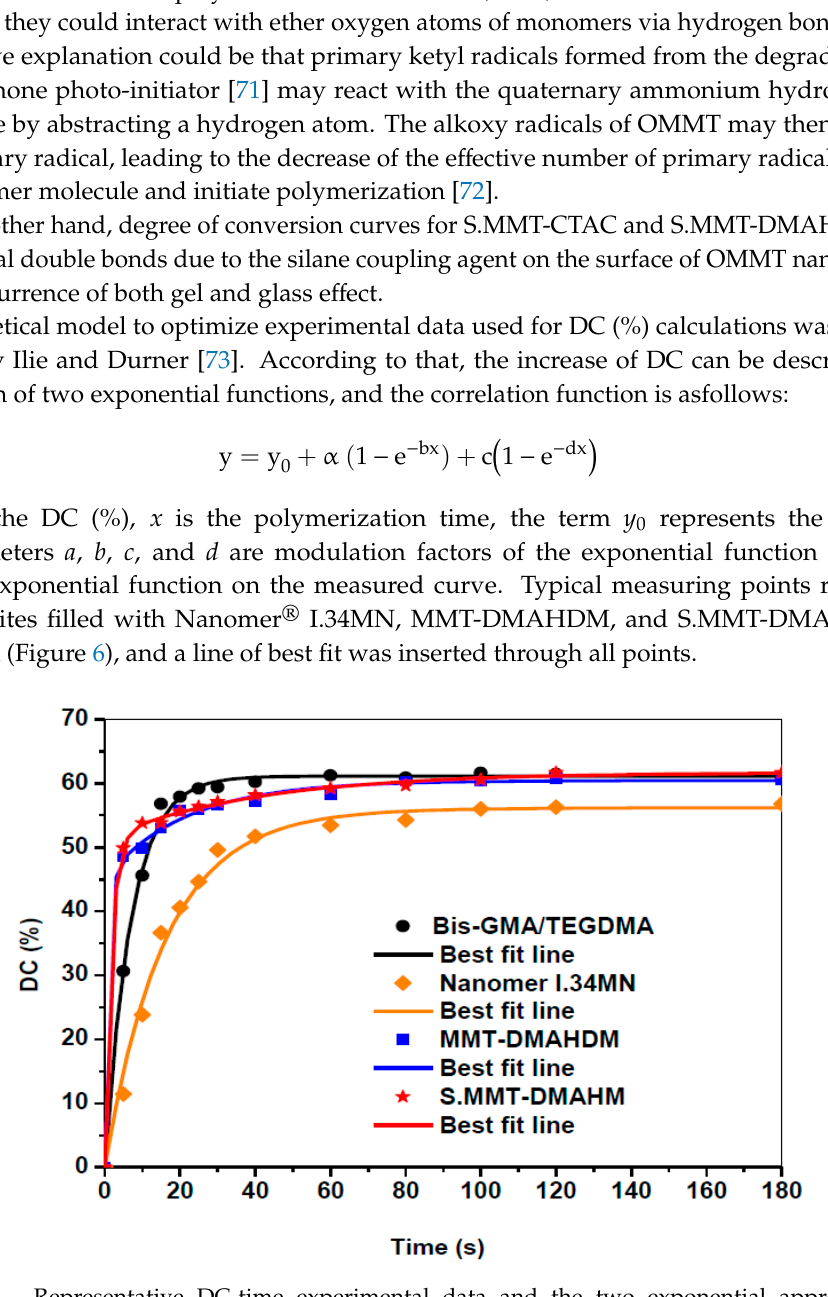
Figure 6. Representative DC-time experimental data and the two exponential approximate functions, for pure Bis-GMA/TEGDMA matrix and nanocomposites filled with Nanomer ® I.34MN, MMT-DMAHDM and S.MMT-DMAHDM. Lines of best fit are drawn through all experimental points of the approximate function.